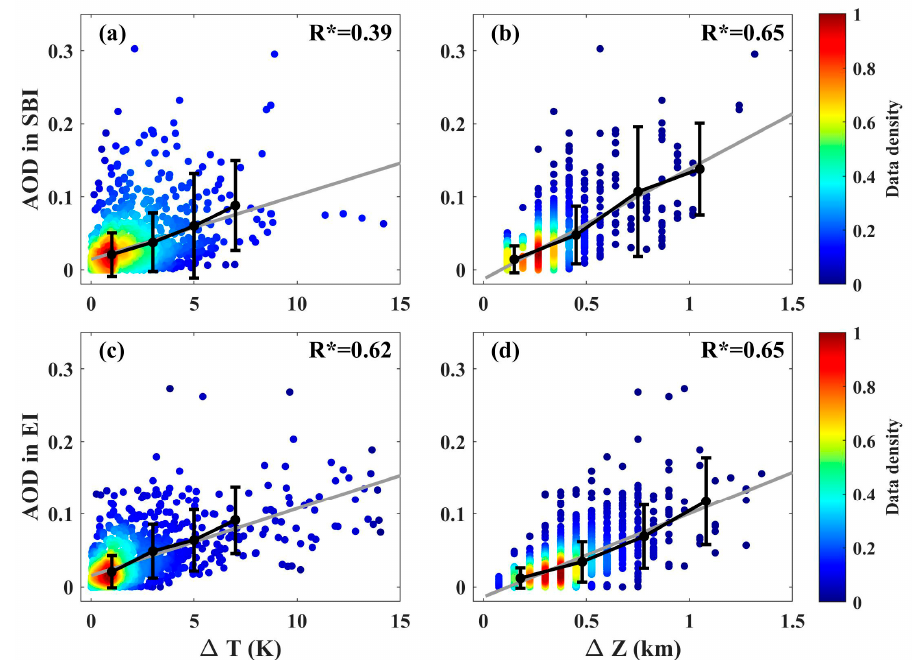
Figure 9. The correlation of ( a ) ∆ T with AOD in SBI, ( b ) ∆ Z with AOD in SBI, ( c ) ∆ T with AOD in EI, ( d ) ∆ Z with AOD in EI. The gray, black line and color bar indicate the linear fitting curve, error bars and the data density, respectively. The asterisks indicate that it passed the significance test ( p < 0.05).